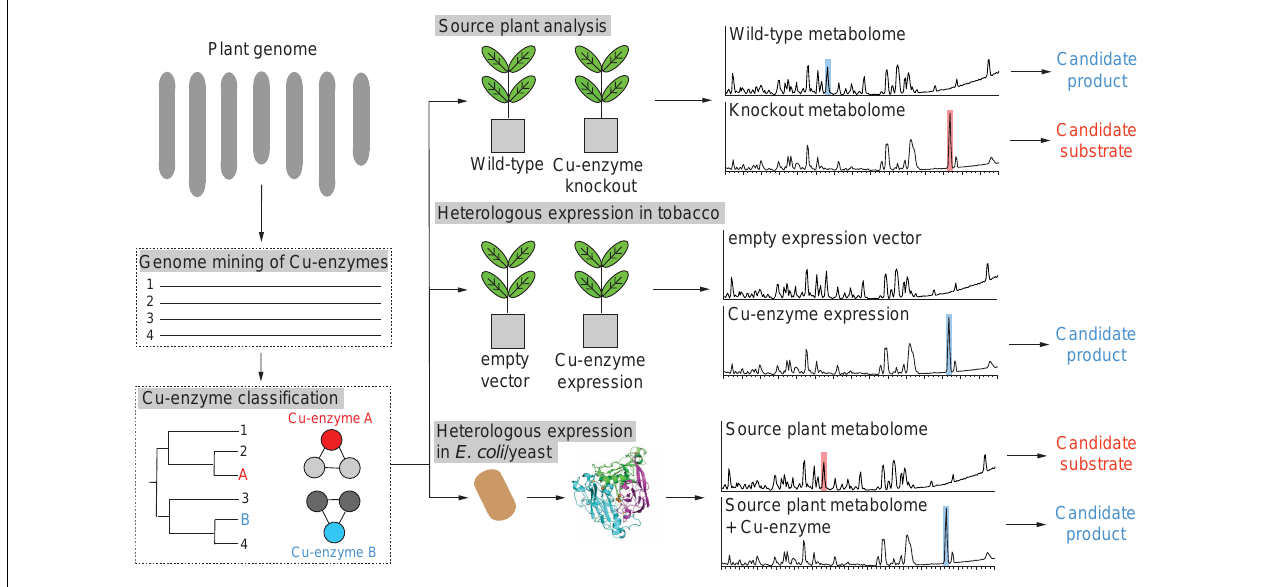
FIGURE 9 | Strategies for characterization of copper metalloenzymes from plant